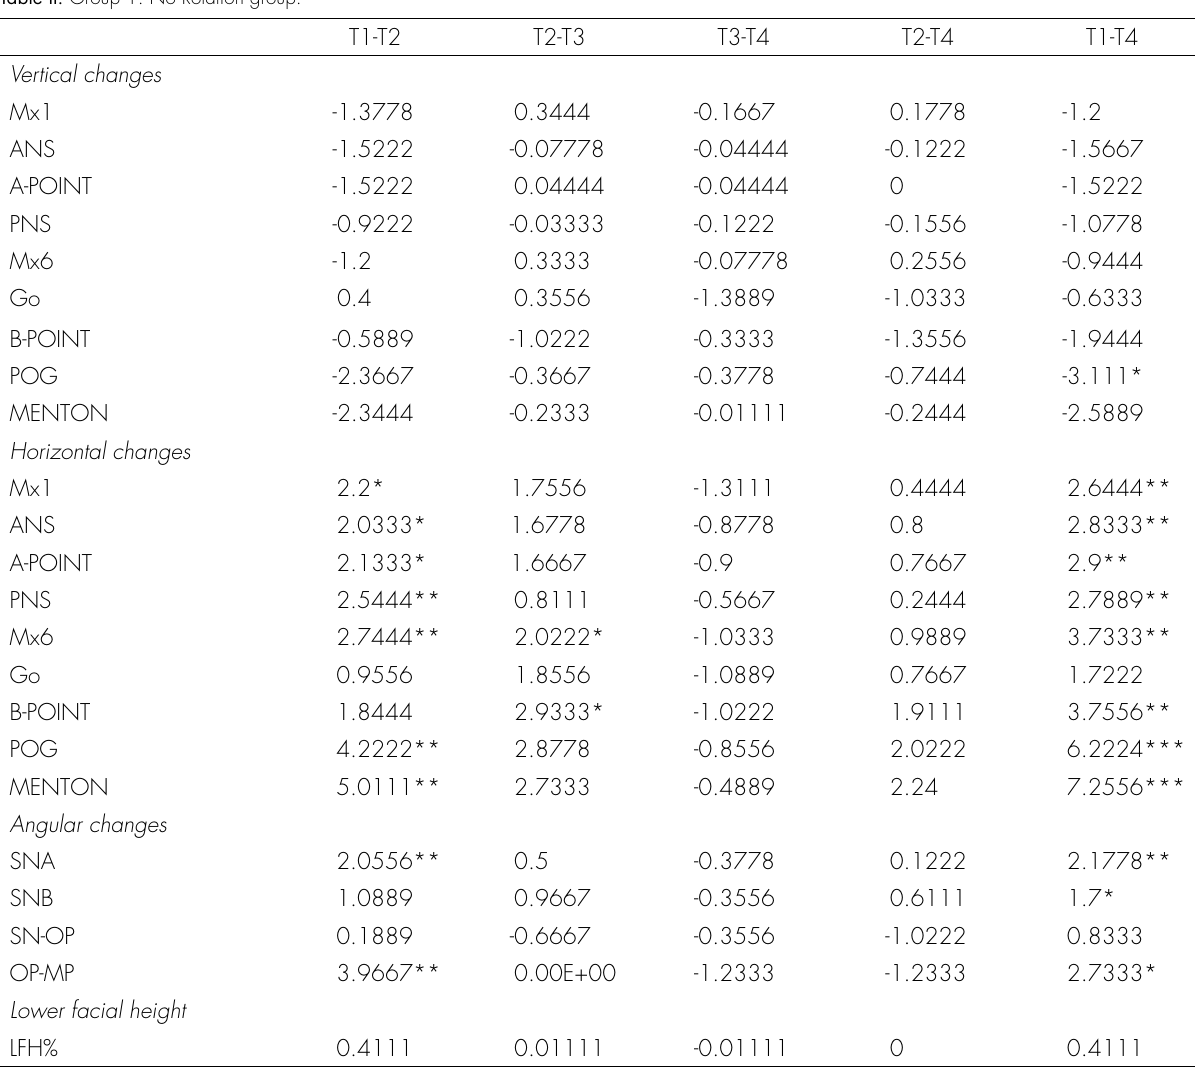
Table II. Group 1: No Rotation